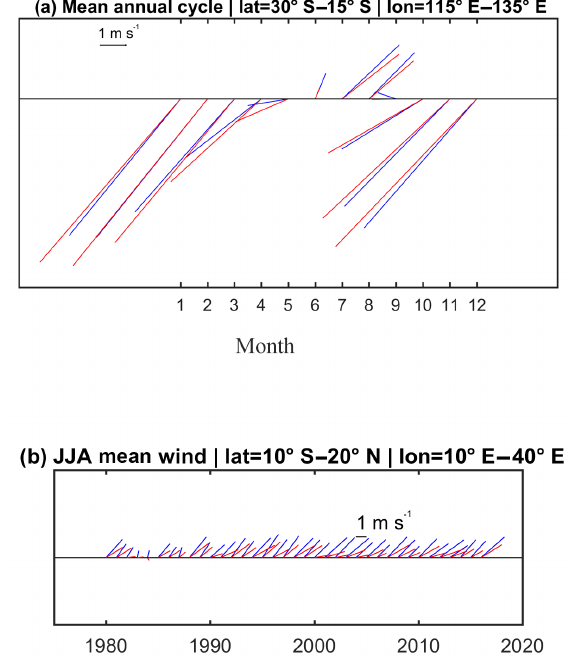
Figure 13. Time series of mean wind vectors for a box over the eastern Sahel (see Fig. 12), using ERA-Interim (blue) and MERRA- 2 (red) data, for the 1980 2016 period: mean annual cycle (a) and the monthly time series for the JJA season (b)